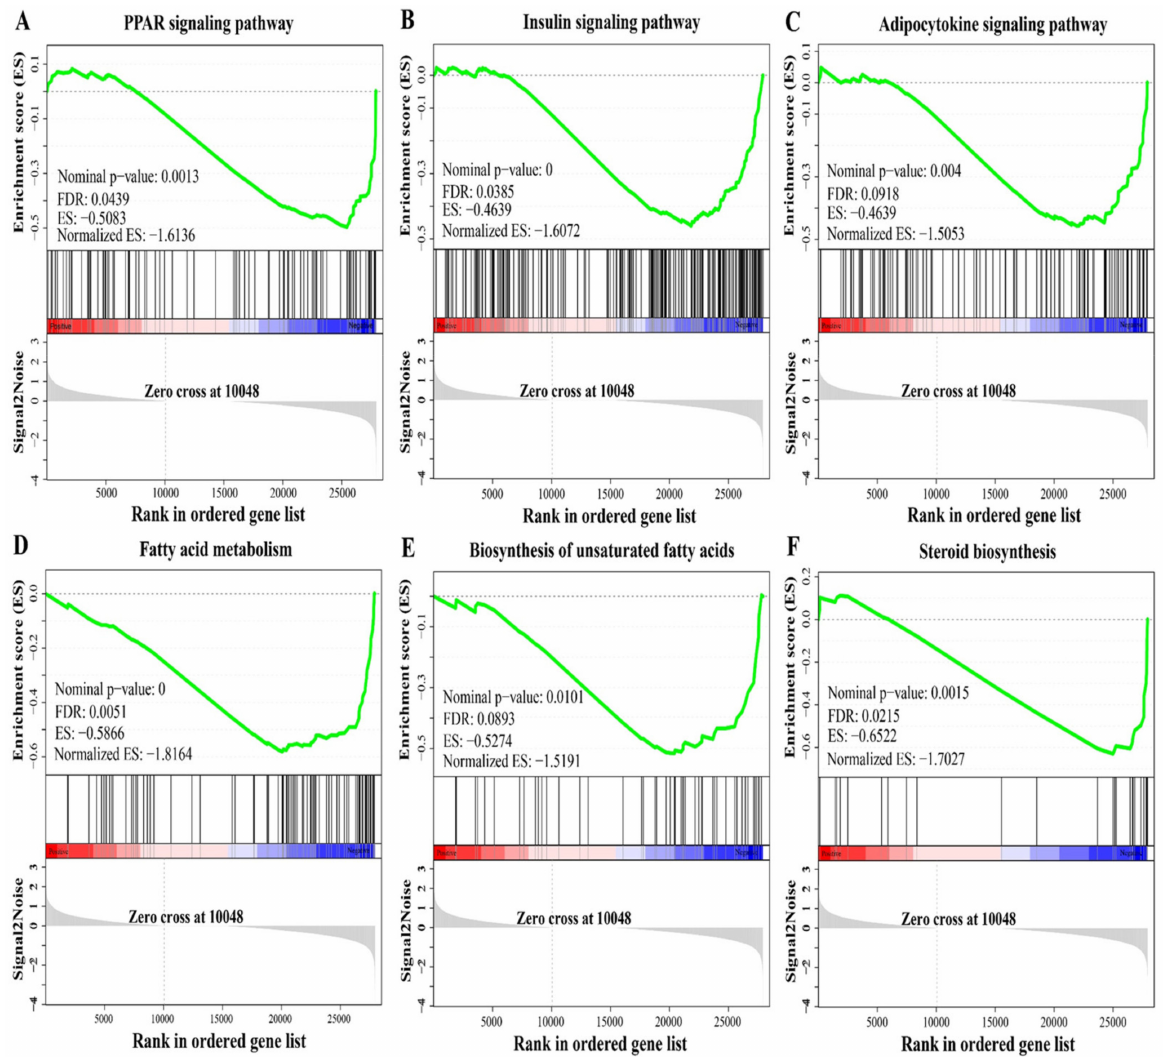
Figure 7. Changes in lipid metabolism-related pathways identified using GSEA in the liver of M. salmoides between the low-density group (LL) and the high-density group (HL). ( A ) PPAR signaling pathway. ( B ) Insulin signaling pathway. ( C ) Adipocytokine signaling pathway. ( D ) Fatty